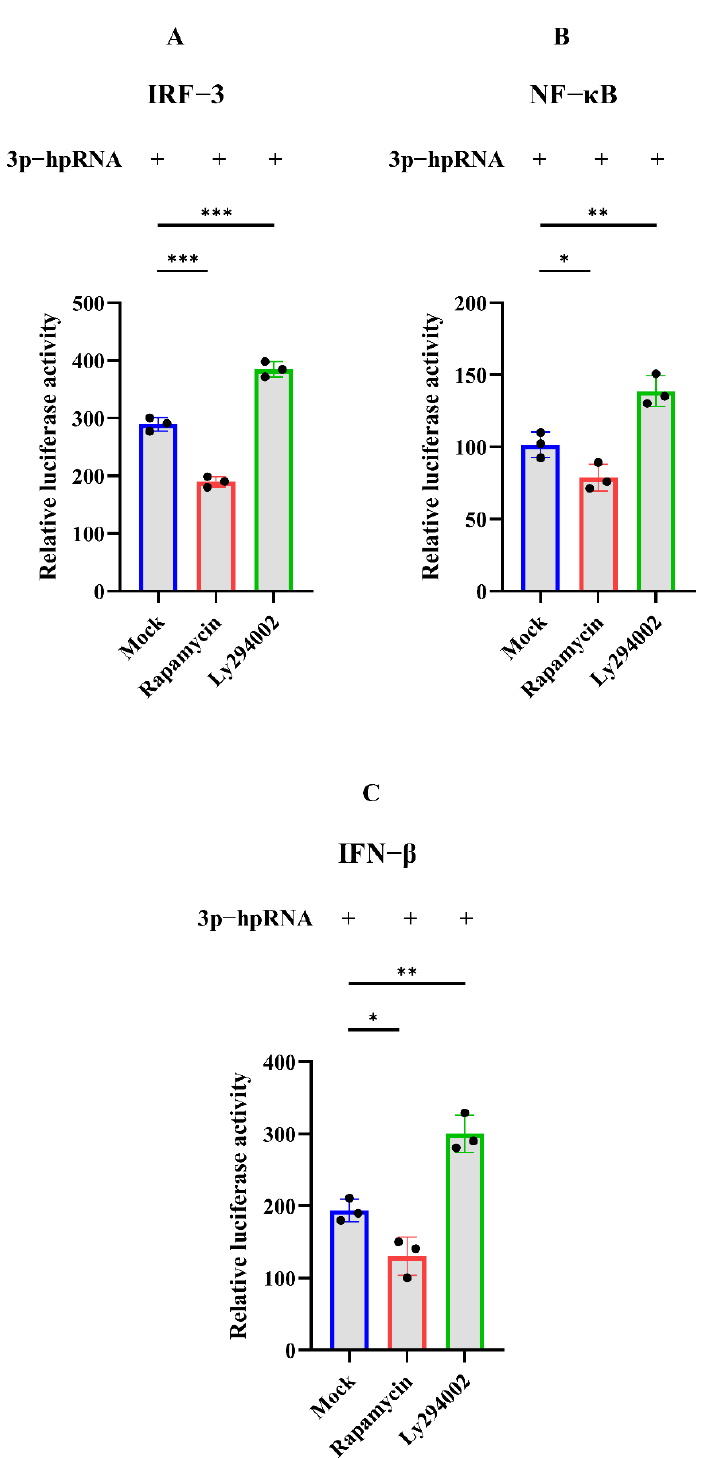
Figure 5. Dual-luciferase assay of 3p-hpRNA stimulation with autophagy-related treatment. HEK 293T cells were transfected with the reporter plasmids and 3p-hpRNA. After 12 h transfection, cells were treated with rapamycin (1 µ M) and ly294002 (20 µ M) for 12 h, respectively. ( A ) IRF-3 ( B ) NF- κ B, and ( C ) IFN- β , promoter activity in the cells was evaluated for quantification analysis after 24 h transfection. Samples were analyzed in three independent experiments ( * p < 0.05, ** p < 0.01, *** p < 0.001).